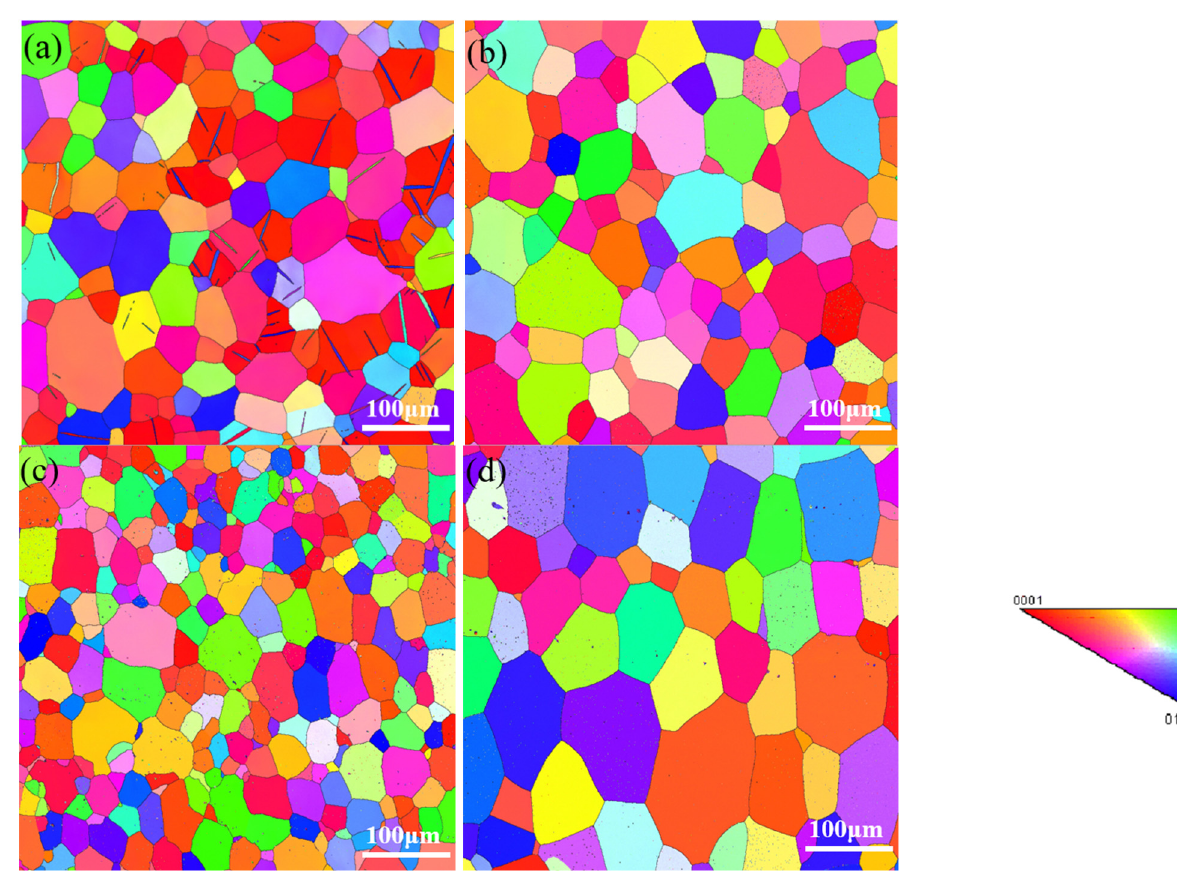
Figure 7. Grain information by EBSD in ( a ) WQ (20 °C), ( b ) WQ (100 °C), ( c ) AC and ( d ) WQ (100 °C) with aging.